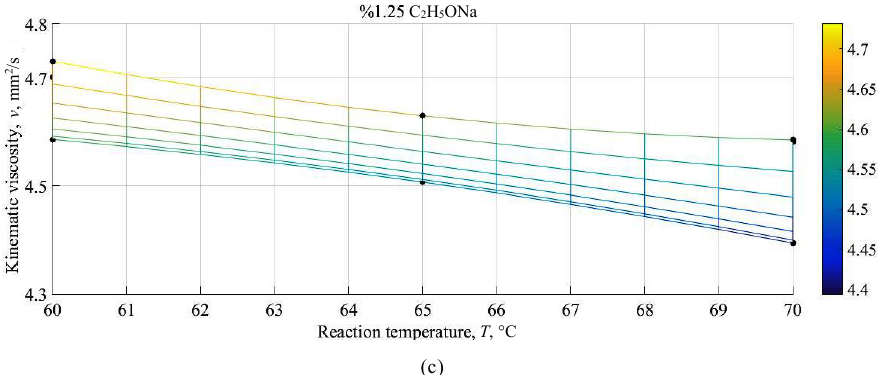
Fig. 6. Variation in ethyl ester viscosity (a) vs. reaction temperature and alcohol/oil molar ratio simultaneously; (b) alcohol/oil molar ratio; (c) reaction temperature for the catalyst concentration of 1.25